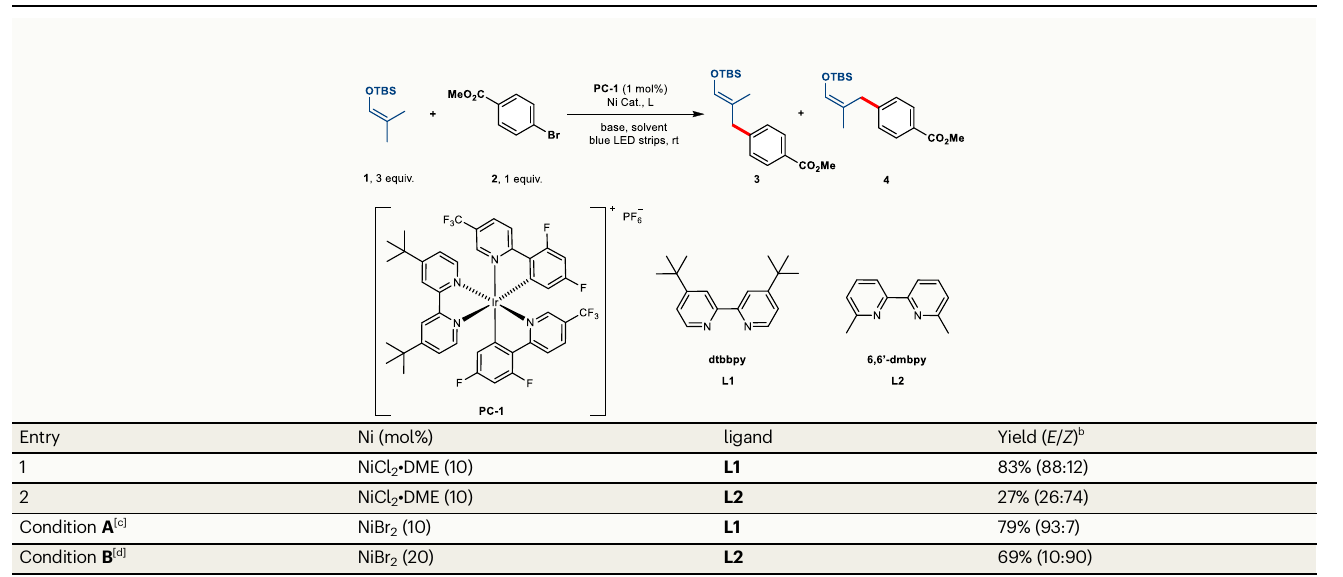
Table 1 | Optimization of the reaction conditions